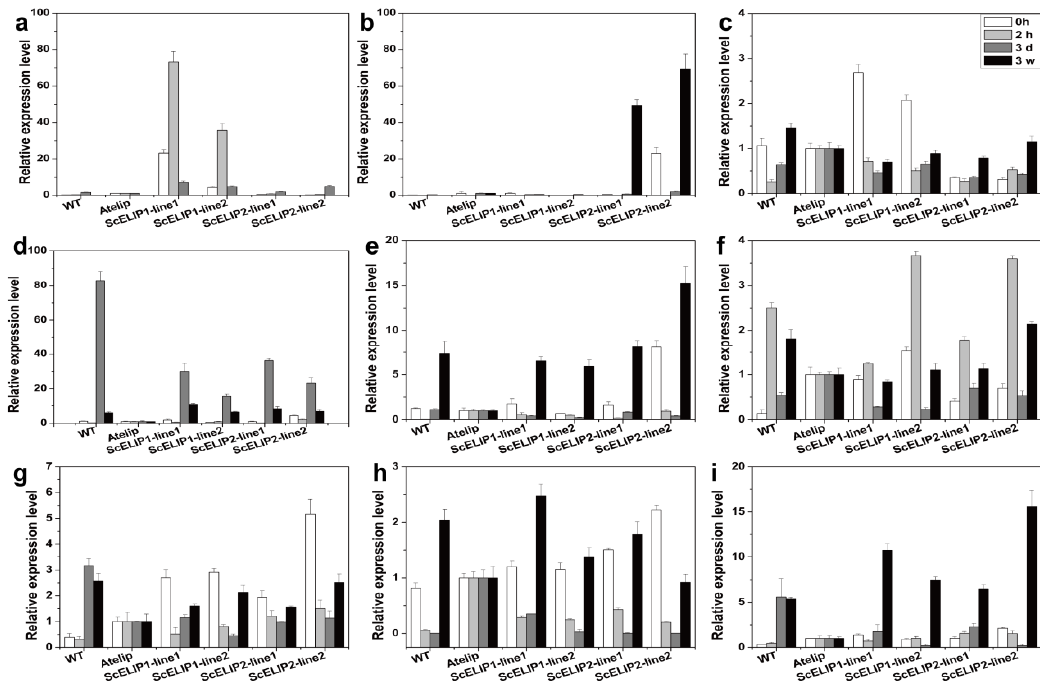
Figure 8. Twelve photosynthesis genes transcript relative abundance assessments in Arabidopsis thaliana di ff erent genotypes (WT, Atelip , transgenic lines) exposed to high-light treatments (1000 µ mol / m 2 / s) for various times. Error bars represent the SD of three biological repeats. Relative expression values were obtained from 2 − ∆∆ C t comparing WT and the transgenic lines with the Atelip mutant, respectively. ScELIP1 : The inserted S. caninervis ELIP1 coding sequence ( a ), ScELIP2 : The inserted S. caninervis ELIP2 coding sequence ( b ), PSBS : The native Arabidopsis PSII CP22 protein gene ( PSBS ) transcript ( c ), OHP : The native Arabidopsis one-helix protein gene ( OHP ) transcript ( d ), OHP2 : The native Arabidopsis one-helix protein 2 gene ( OHP2 ) transcript ( e ), SEP2 : The native Arabidopsis two-helix protein gene ( SEP ) transcript ( f ), LHCA2 : The native Arabidopsis PSI antenna protein gene ( LHCA2 ) transcript ( g ), LHCB4.2 : The native Arabidopsis PSII CP29 antenna protein gene ( LHCB4.2 ) transcript ( h ), PSBD : The native Arabidopsis PSII D2 protein gene ( PSBD ) transcript ( i